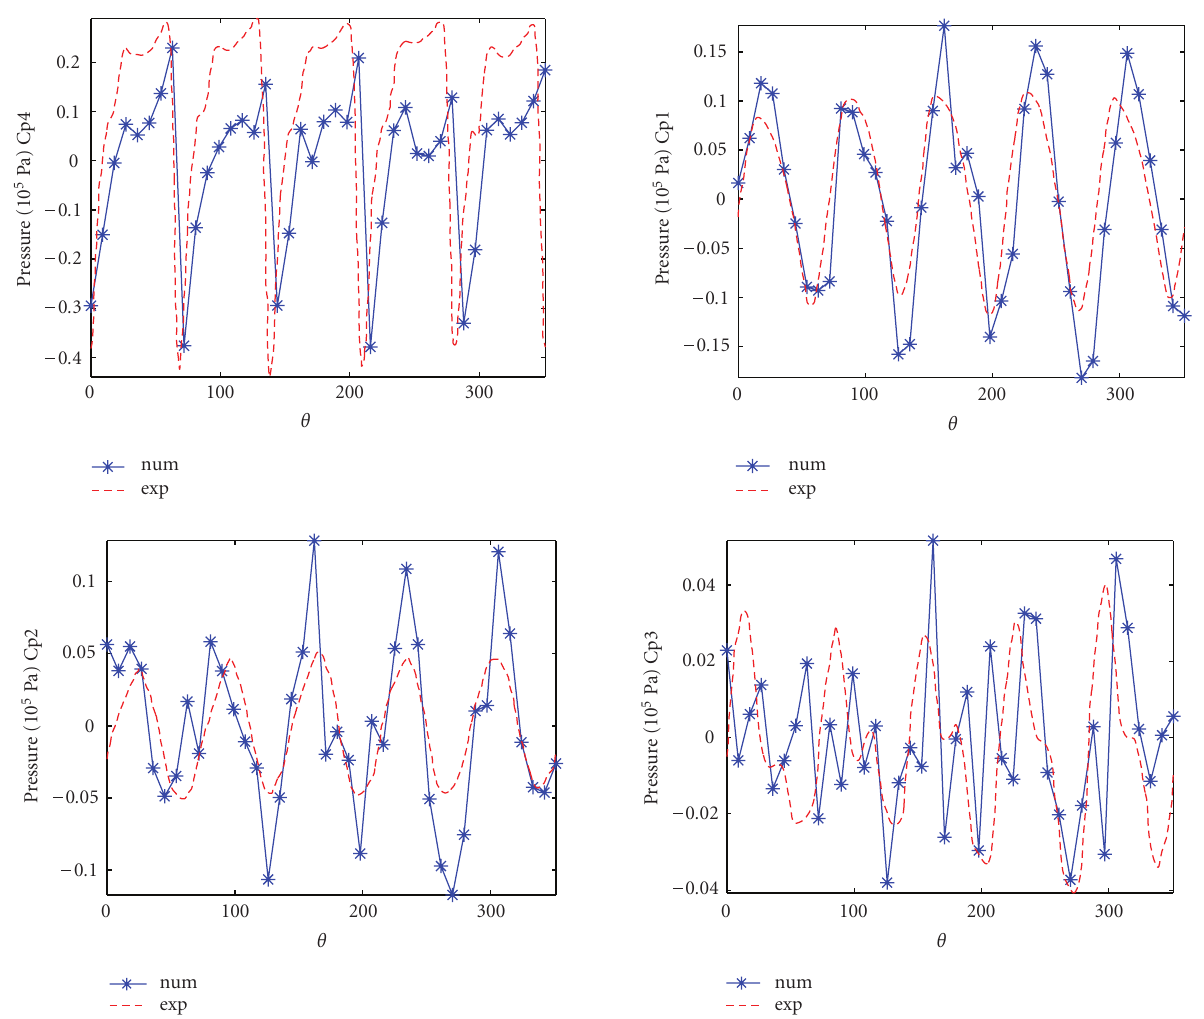
Figure 18: Computed and experimental pressure fluctuations over one impeller revolution—original impeller—sensors Cp4, Cp1, Cp2, and Cp3 at BEP; num = numerical, exp =